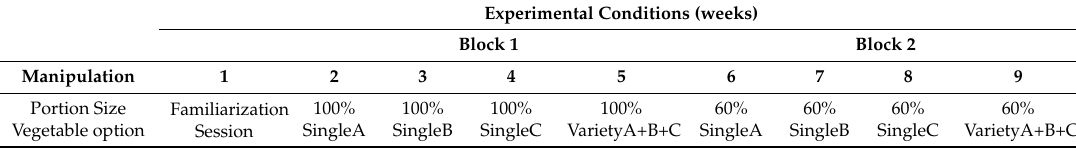
Table 1. Experimental design.